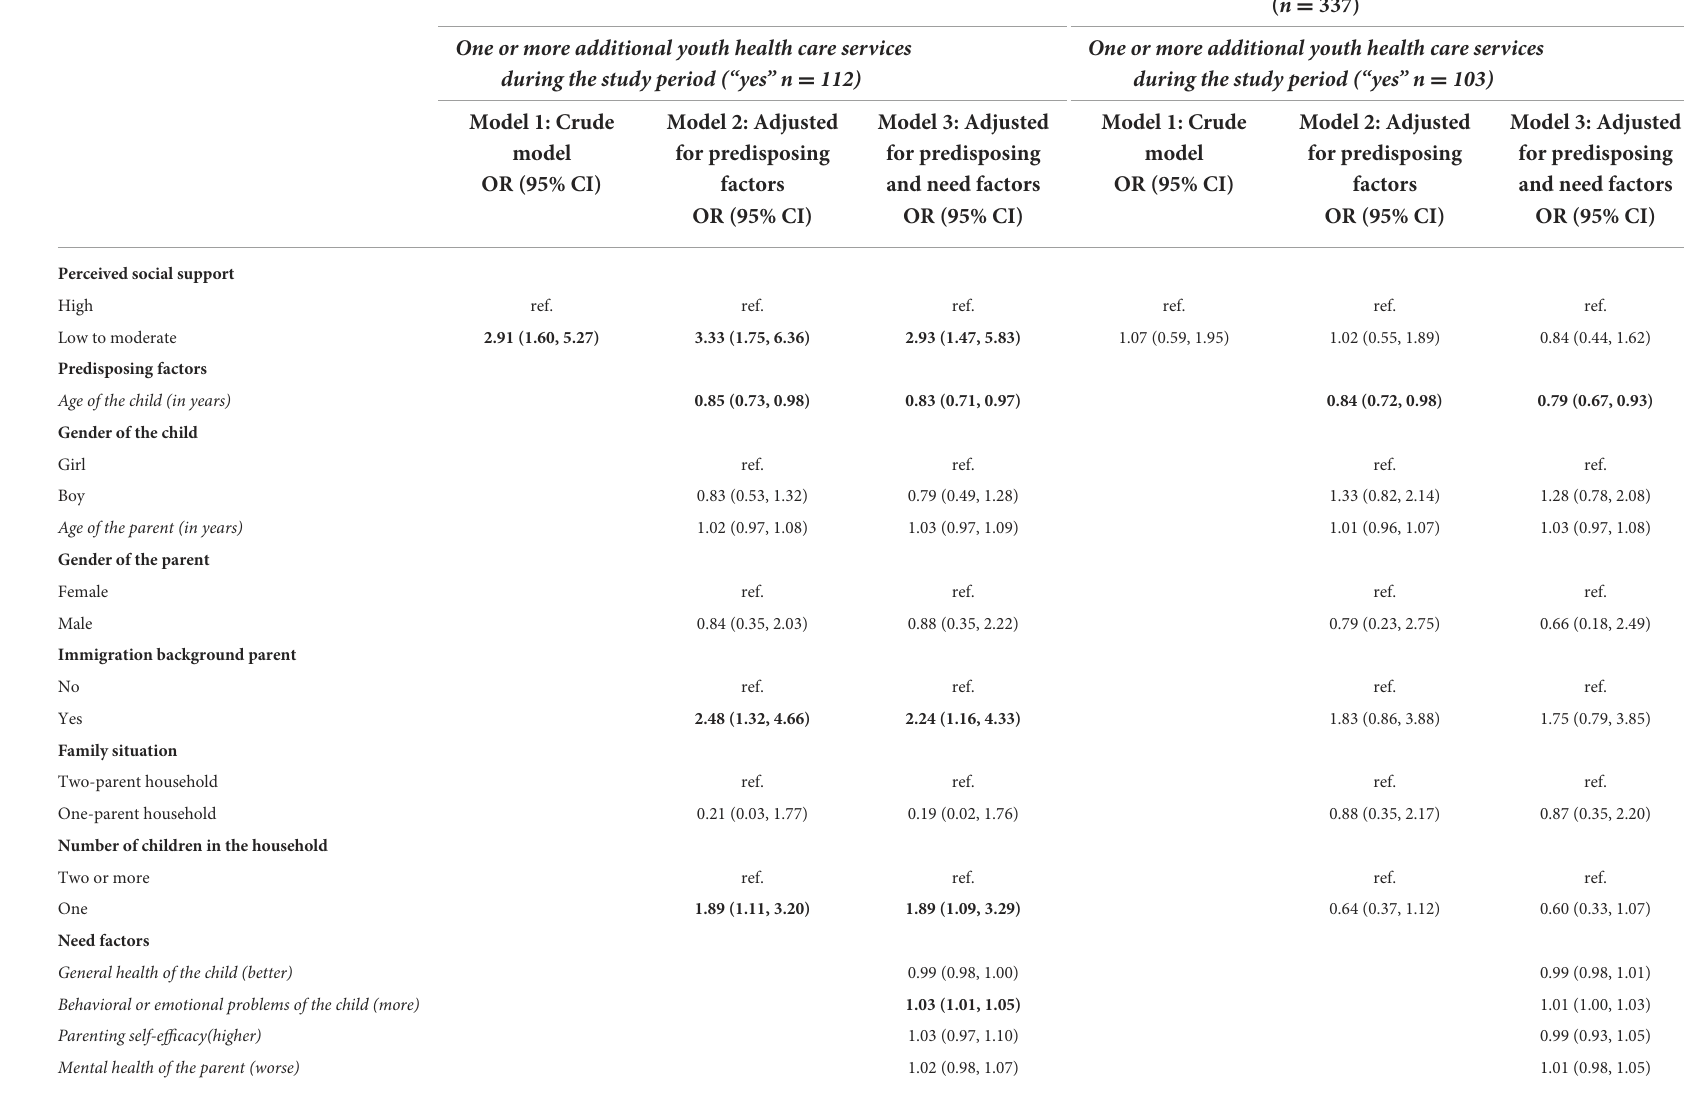
TABLE 4 Stratified logistic regression models on the association between social support and the use of additional community youth health care services during the study period (1.5 year) among parents of children aged 1–7 years participating in the CIKEO study ( n = 749); stratified by educational